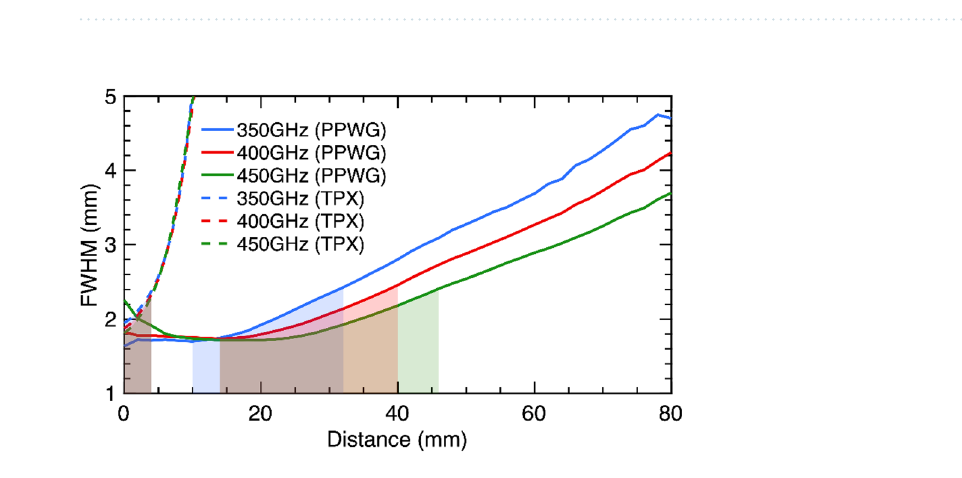
Figure 2. Experimental results for the longitudinal propagation of the normalized electric field at ( a ) 350 GHz, ( b ) 400 GHz and ( c ) 450 GHz. The false color image represents the amplitude of the E-field at a particular frequency. The propagation of the THz beam goes from left to right.